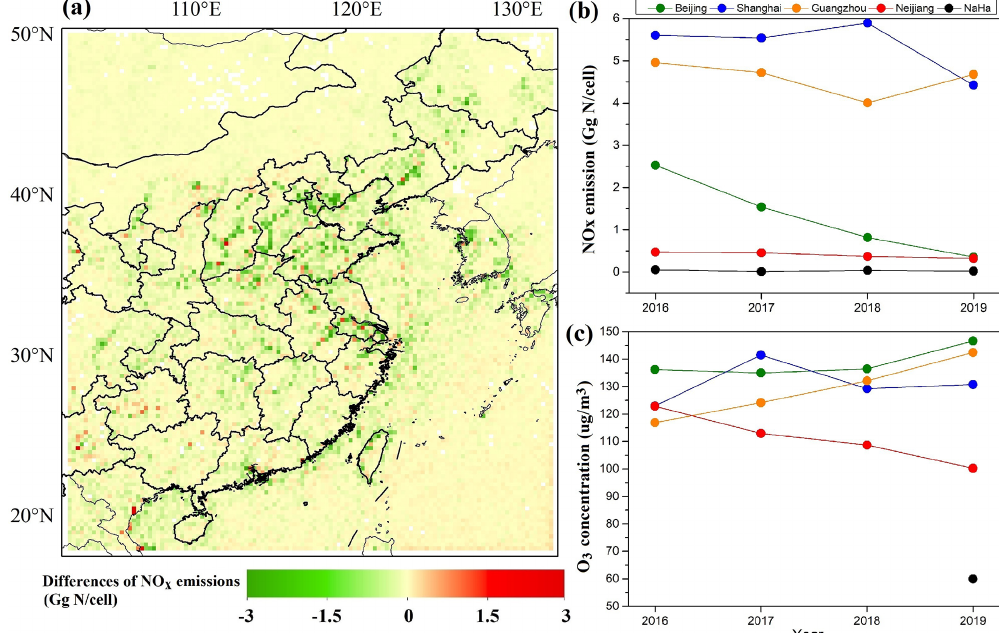
Figure 5. (a) Differences in total NO x emissions derived from OMI observations in summer in east China between 2019 and 2016. (b) Vari- ations in total NO x emissions in five cities (Beijing, Shanghai, Guangzhou, Neijiang, and Naha) in summer from 2016 to 2019. (c) Variations in mean ground-based O 3 concentrations in five cities in summer from 2016 to